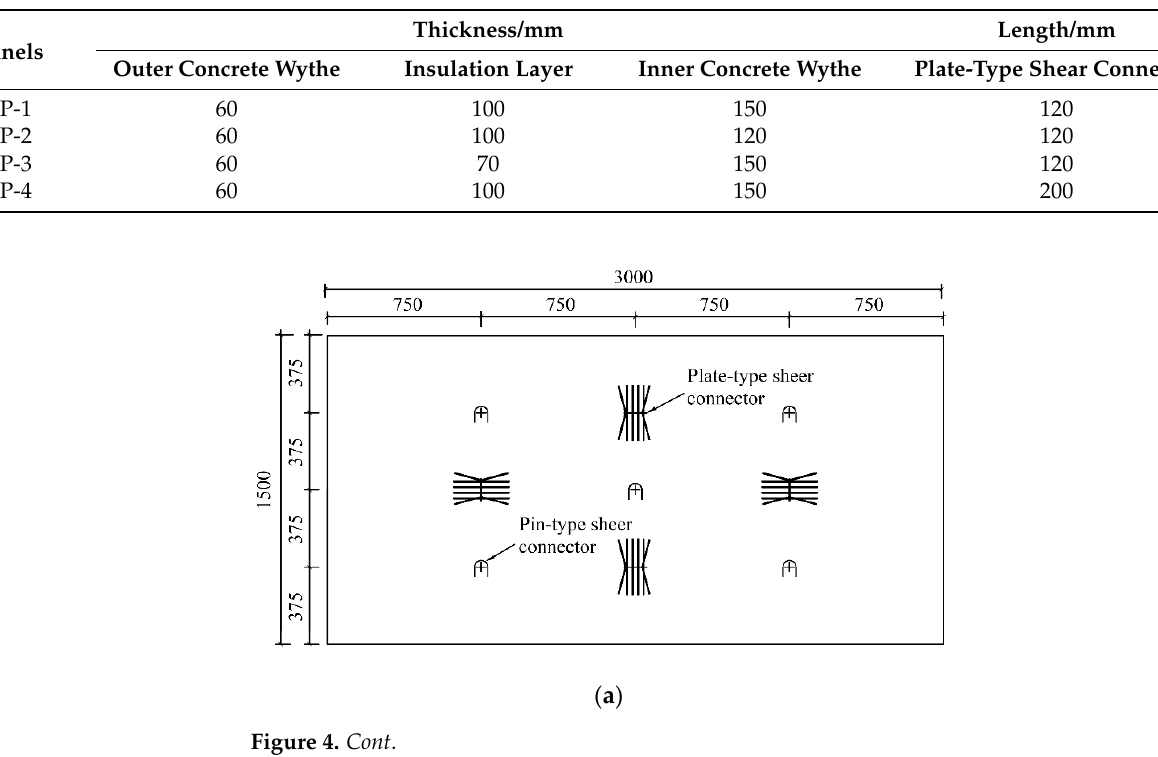
Figure 3. Specimen size and reinforcement: ( a ) SP-1 and SP-4; ( b ) SP-2; ( c ) SP-3. Table 1. Basic parameters of the specimen.